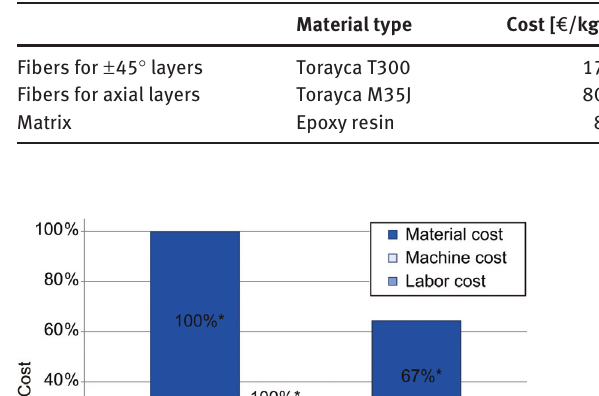
Table 8 Used materials and estimated material